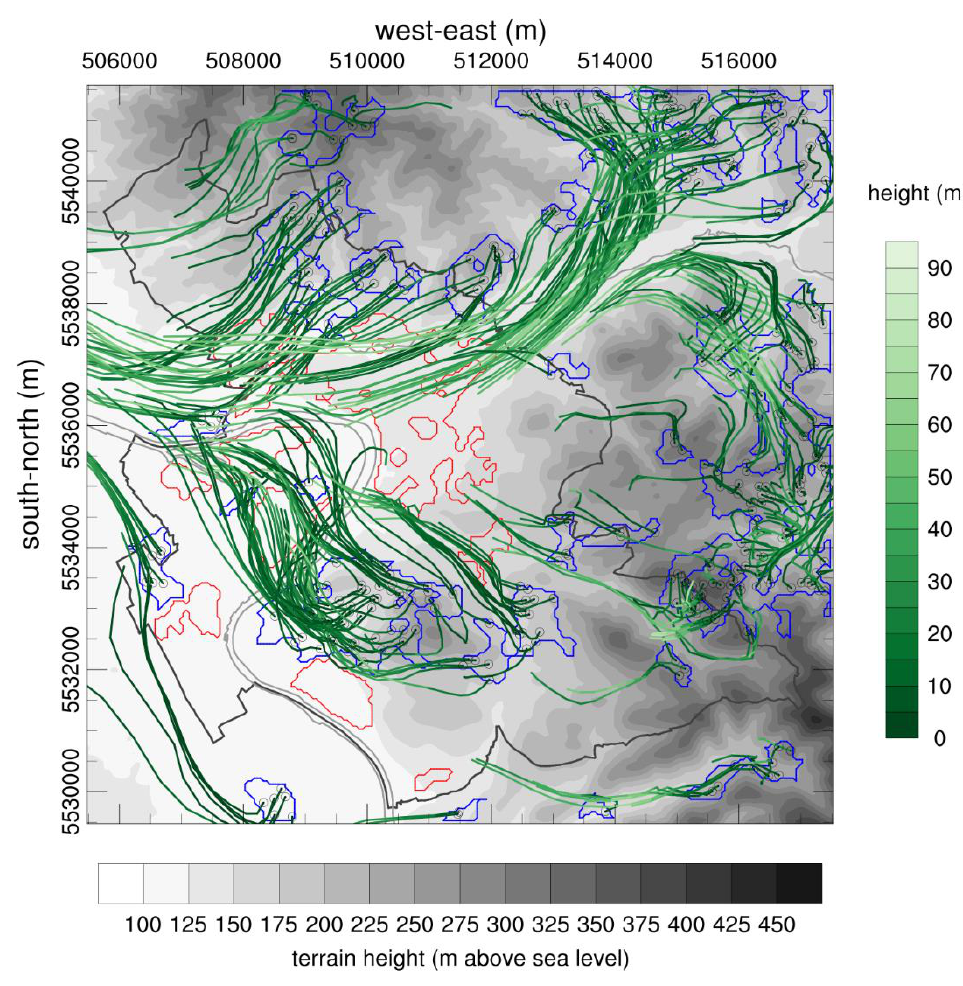
Figure 12. Forward trajectories map of the 12 km × 12 km subdomain from 01:00 to 03:00 CEST with trajectory heights above ground level in green color shading. Trajectories are released in the cold air formation areas (blue) identified by z-transformation. Additionally shown are the thermal hot spots in red, rivers in light grey, the city border of Aschaffenburg in black and terrain elevation in grey color shading.